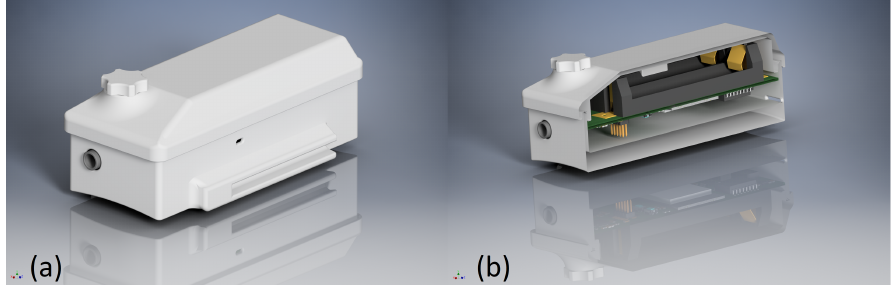
Figure 4. Housing of SPECTRE 3.0. ( a ) Exterior view of the device’s housing showing the assembled body and detachable lid and magnet holder. ( b ) Cross-section of the housing showing the placement of the PCB inside.